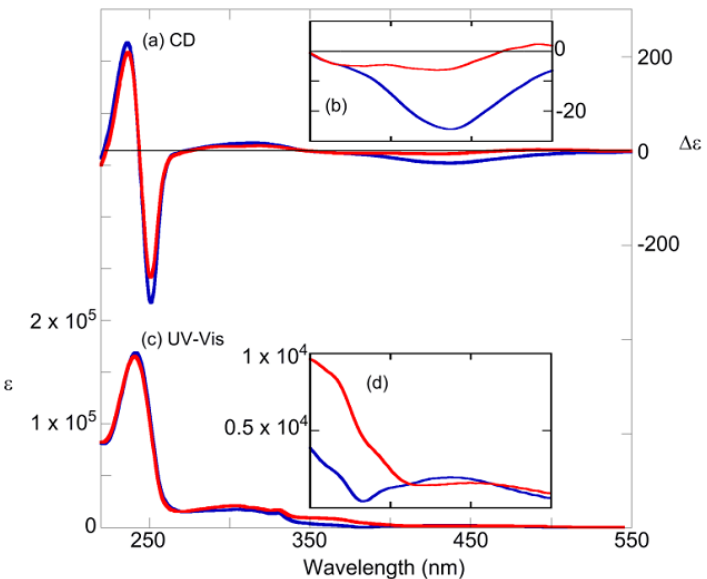
Figure 5. (a, b) CD spectra of ( R )- 7 . (c, d) Absorption spectra of ( R )- 7 . After 365-nm irradiation (blue line), after 436-nm irradiation (red line). Conditions: 1,4-dioxane (1.0 × 10 − 5 M), 20 °C, light path length = 10 mm, irradiation wavelength = 365 nm (10 mW/cm 2 , 100 s) and 436 nm (10 mW/cm 2 , 100